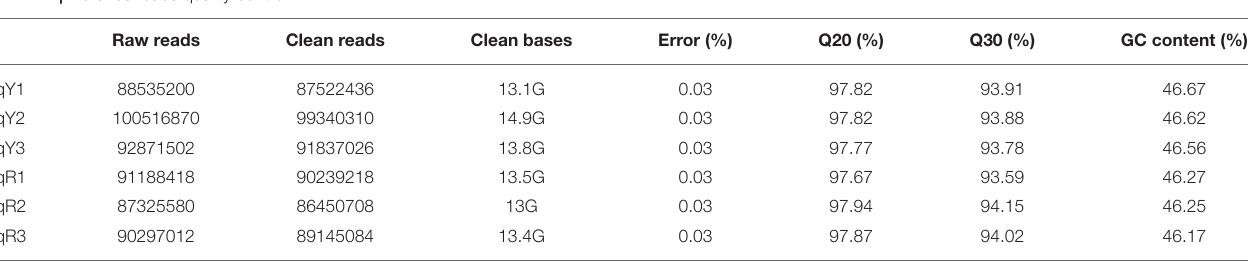
TABLE 1 | Libraries reads quality control.